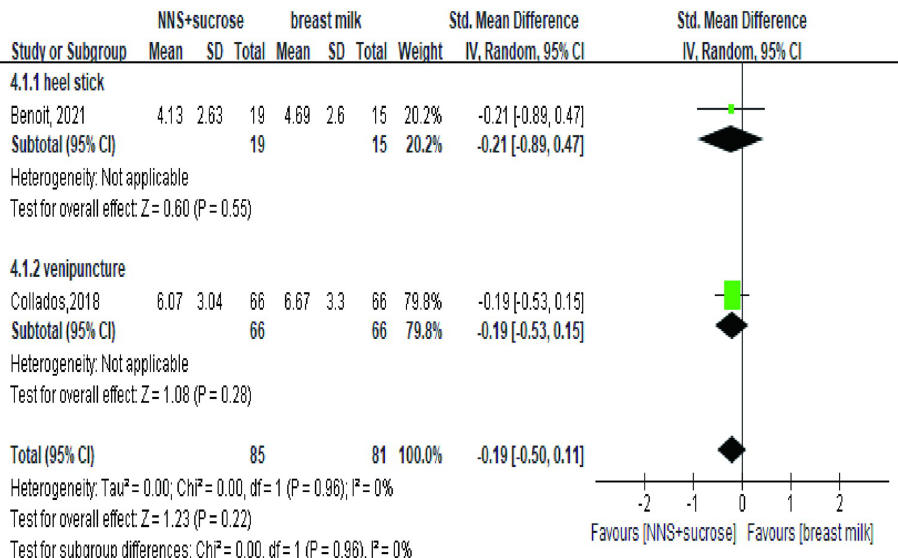
Fig 8. Forest plot of pain score comparing the combined intervention (NNS and sucrose) with breastmilk during the procedures. NNS: nonnutritive sucking.